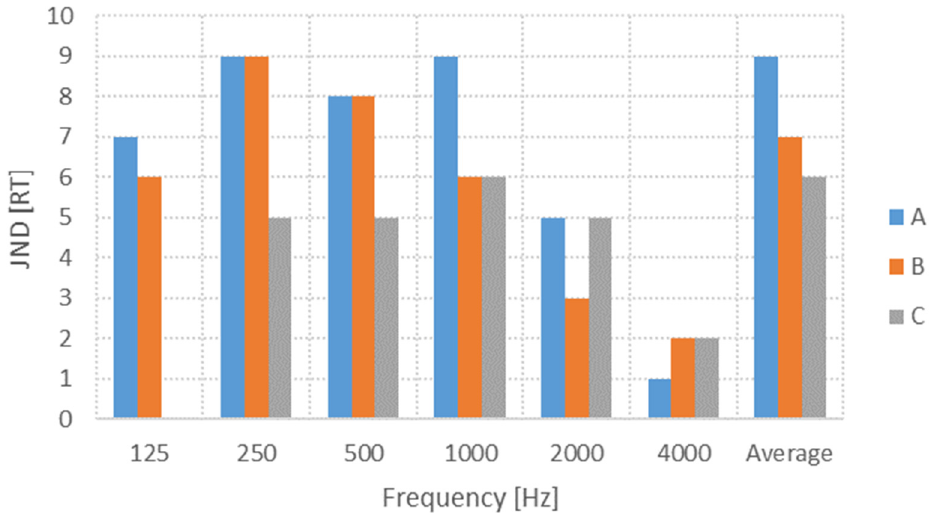
Figure 8. JND for reverberation time (RT) in the auditorium, for the studied variable acoustic